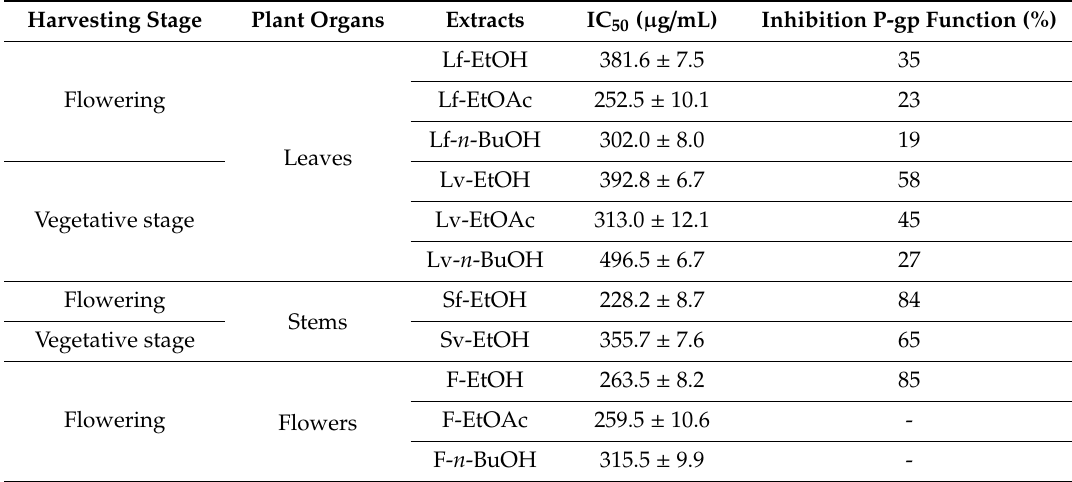
Table 1. Cytotoxicity and inhibitory e ff ects on P-gp function of Ageratina havanensis (Kunth) R. M. King & H. Robinson extracts on breast cancer 4T1